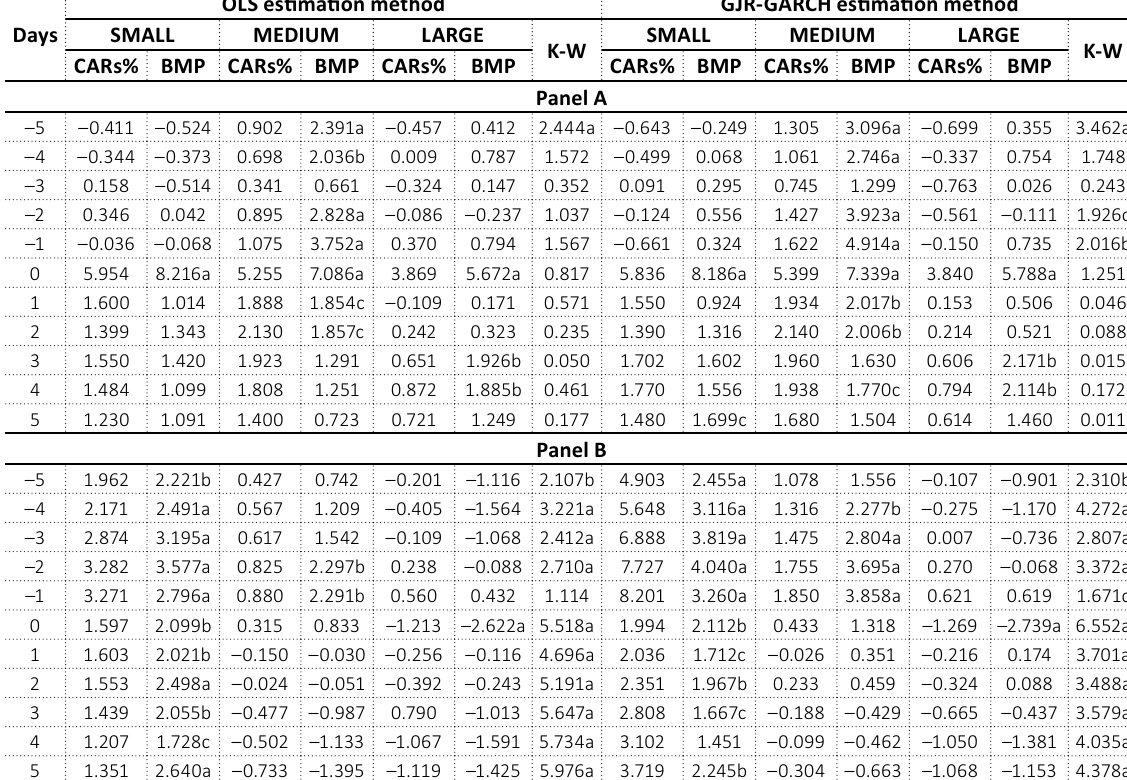
Table 4. Cumulative ARs measures around merger announcements group by trading volume for target and acquirer firms